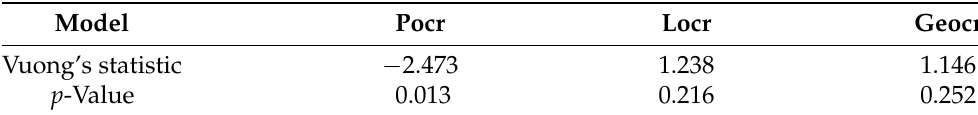
Table 7. Vuong’s statistic and p -value when testing the Bell cure rate model against some alternatives.